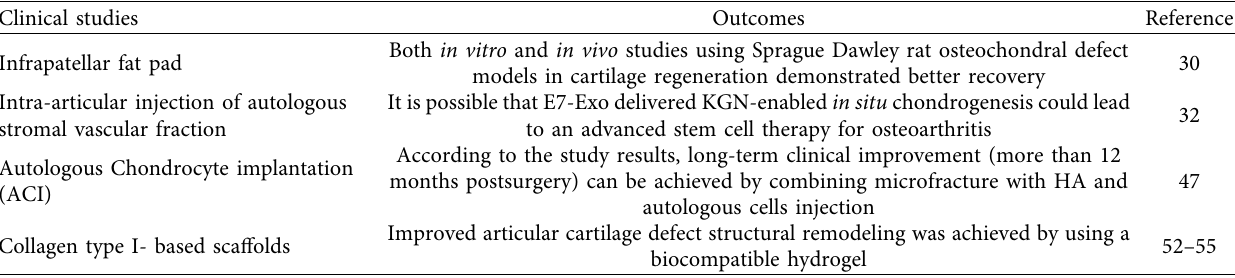
Table 2: Reprehensive clinical studies’